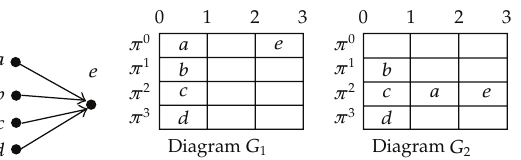
Figure 1: Di ff erence between the problem P | prec; c ij (cid:5) 1; p i (cid:5) 1 | C max and (cid:3) P, grid 2 × 2 (cid:4) | prec; c ij (cid:5) d (cid:3) π i ,π j (cid:4) ; p i (cid:5) 1 | C max